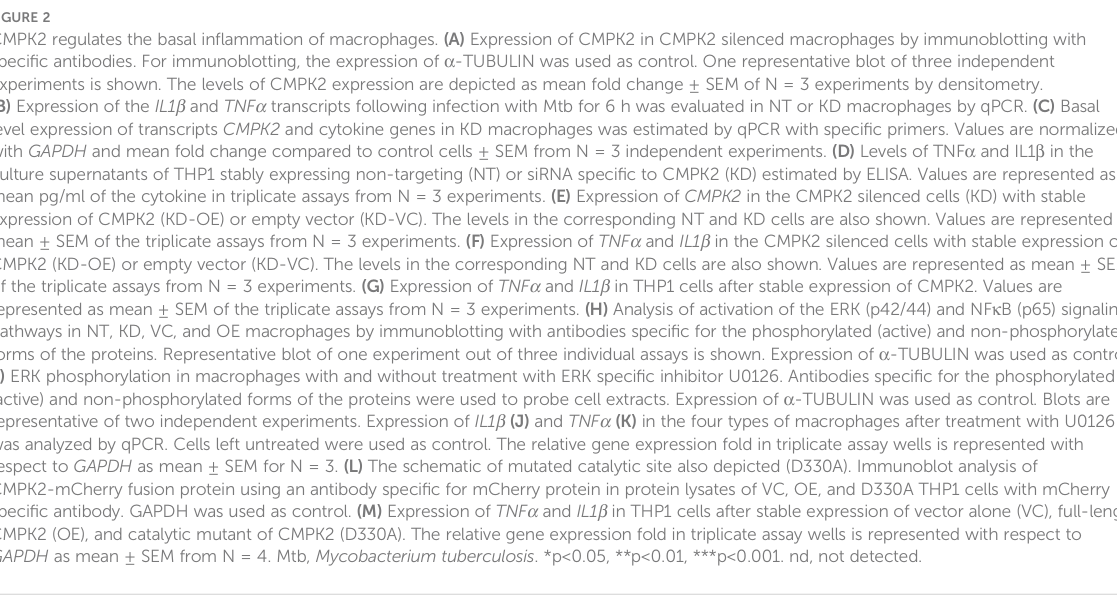
(Figure 2L). In an effort to probe the importance of the kinase domain, we substituted the active site aspartate to alanine